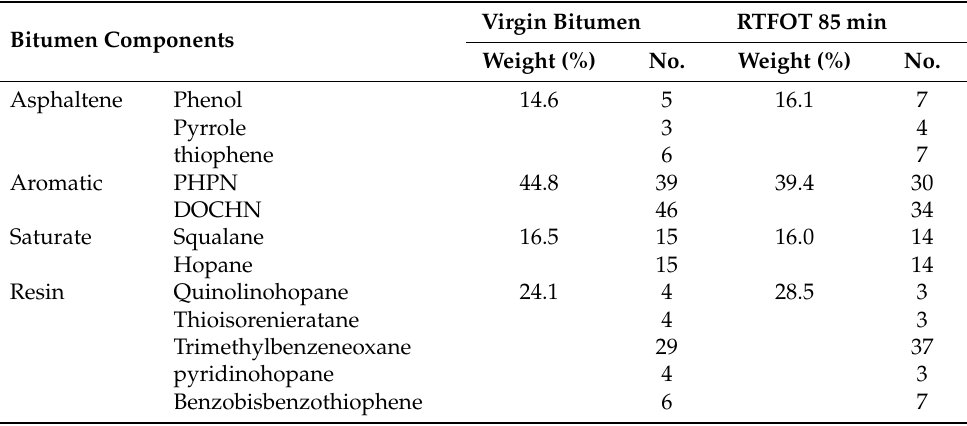
Table 3. Molecular compositions in virgin bitumen and RTFOT 85